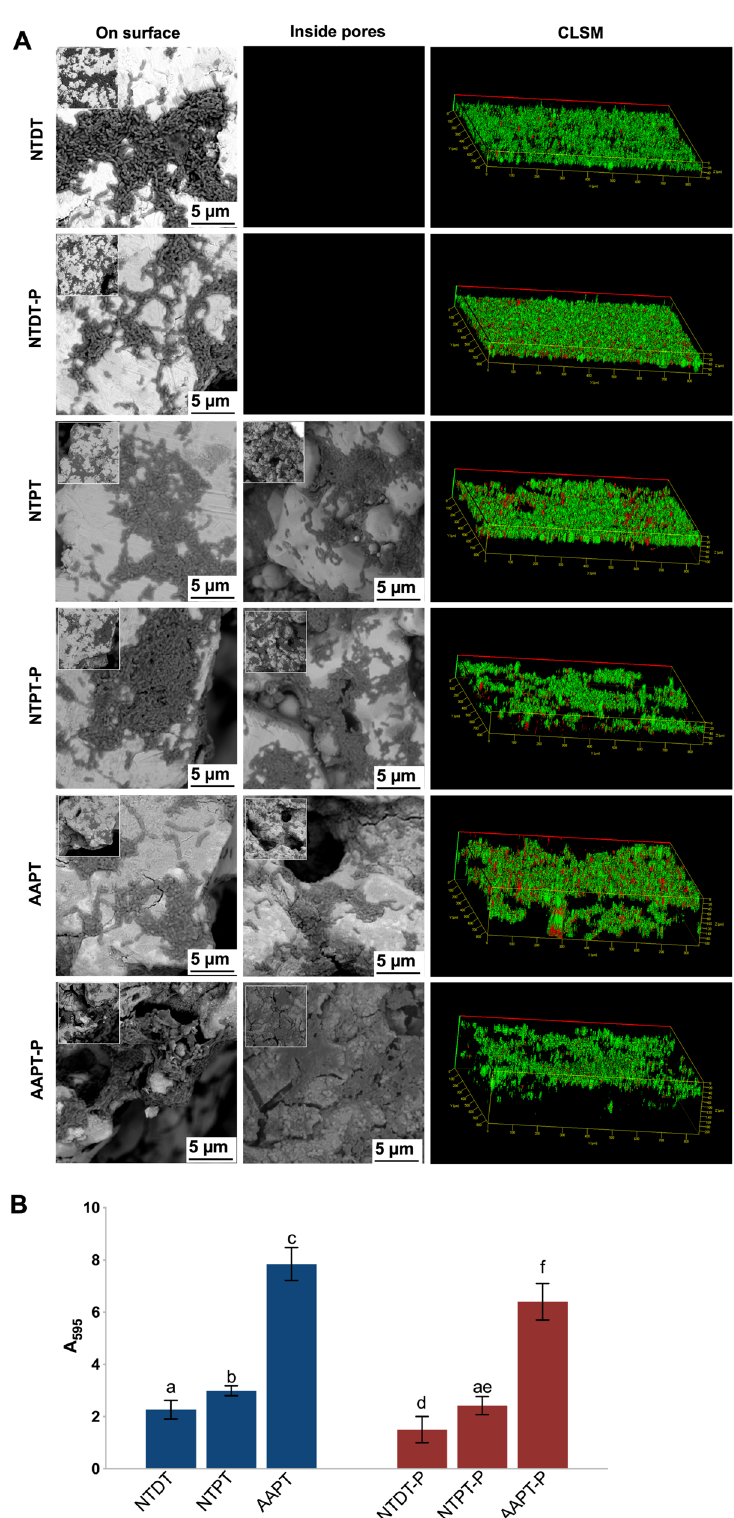
Fig. 3 S. mutans adhesion shortly after the start of the 1 h incubation period on Ti with or without serum precoating. A SEM and CLSM images showed the morphology of bacterial cells adhered to NTDT, NTDT-P, NTPT, NTPT-P, AAPT, and AAPT-P. S. mutans showed a normal shape and structure (long chain). Some scattered S. mutans and small colonies were observed after 1 h of incubation. Bacterial aggregation on AAPT and AAPT-P seemed to be more evident than on NTPT and NTDT as well as on NTPT-P and NTDT-P. B Quanti fi cation of bacterial adhesion in each group was performed by measuring the absorbance at 595 nm ( n = 4). The results showed that bacteria adhered more to porous samples than to dense samples ( p < 0.05) and adhered more to nonprecoated samples than to protein- precoated samples ( p <